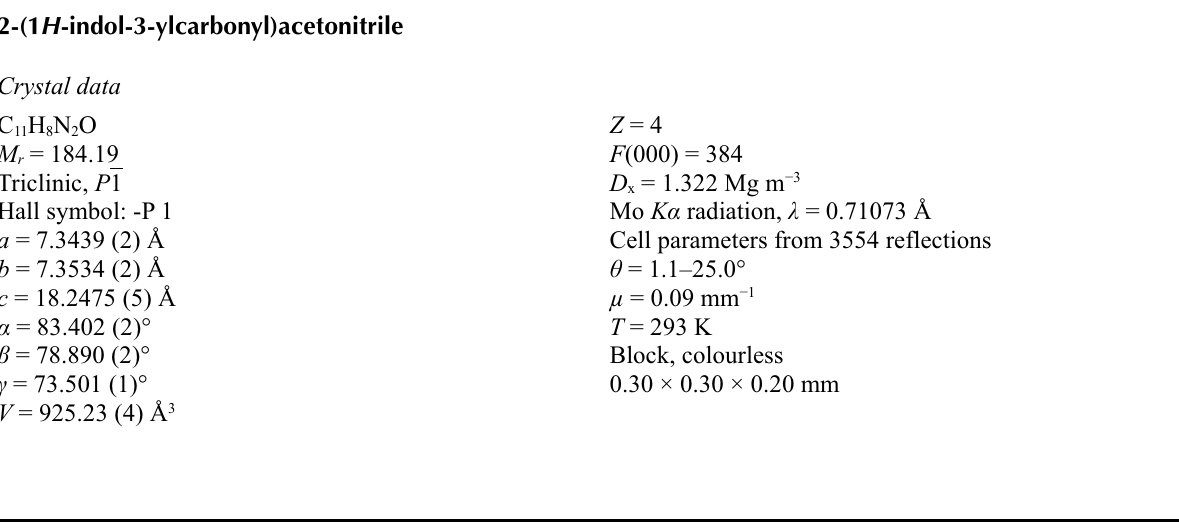
The crystal packing of the molecules viewed down c axis. H atoms not involved in hydrogen bonding have been omitted for